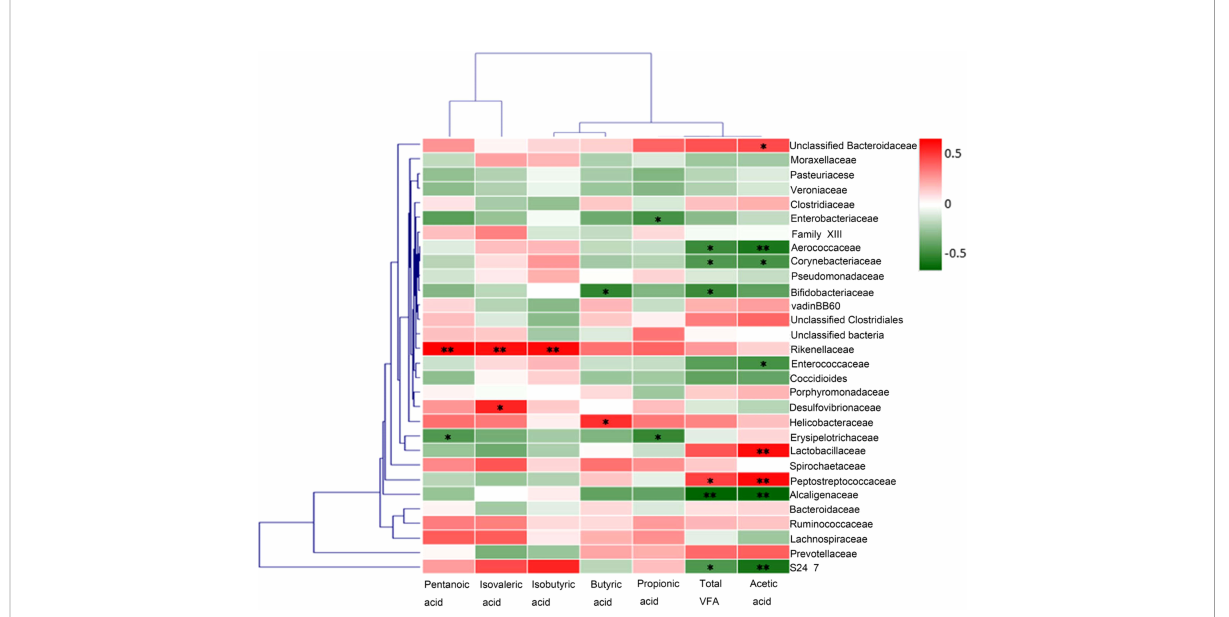
FIGURE 7 Correlation analysis between the abundances of fecal Short-chain fatty acid and representative bacteria. At the level of operational taxonomic units (OTUs), results from Spearman ’ s correlation analysis showed that the abundance of bacteria including Lactobacillaceae and Peptostreptococcaceae were positively correlated with the level of acetic acid in rat fecal samples, while the abundances of bacteria including Aerococcaceae and Alcaligenaceae were negatively correlated with that of acetic acid. * p <0.05, ** p <0.01.